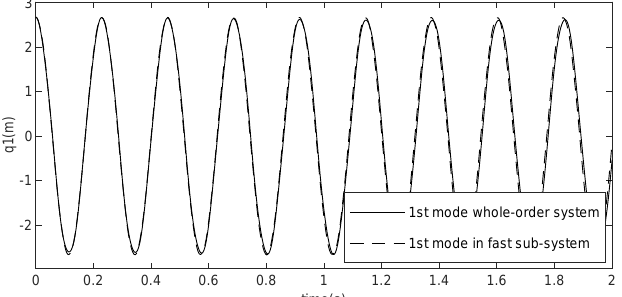
Figure 2. q 1 ( m ) of the original system and the fast subsystem.